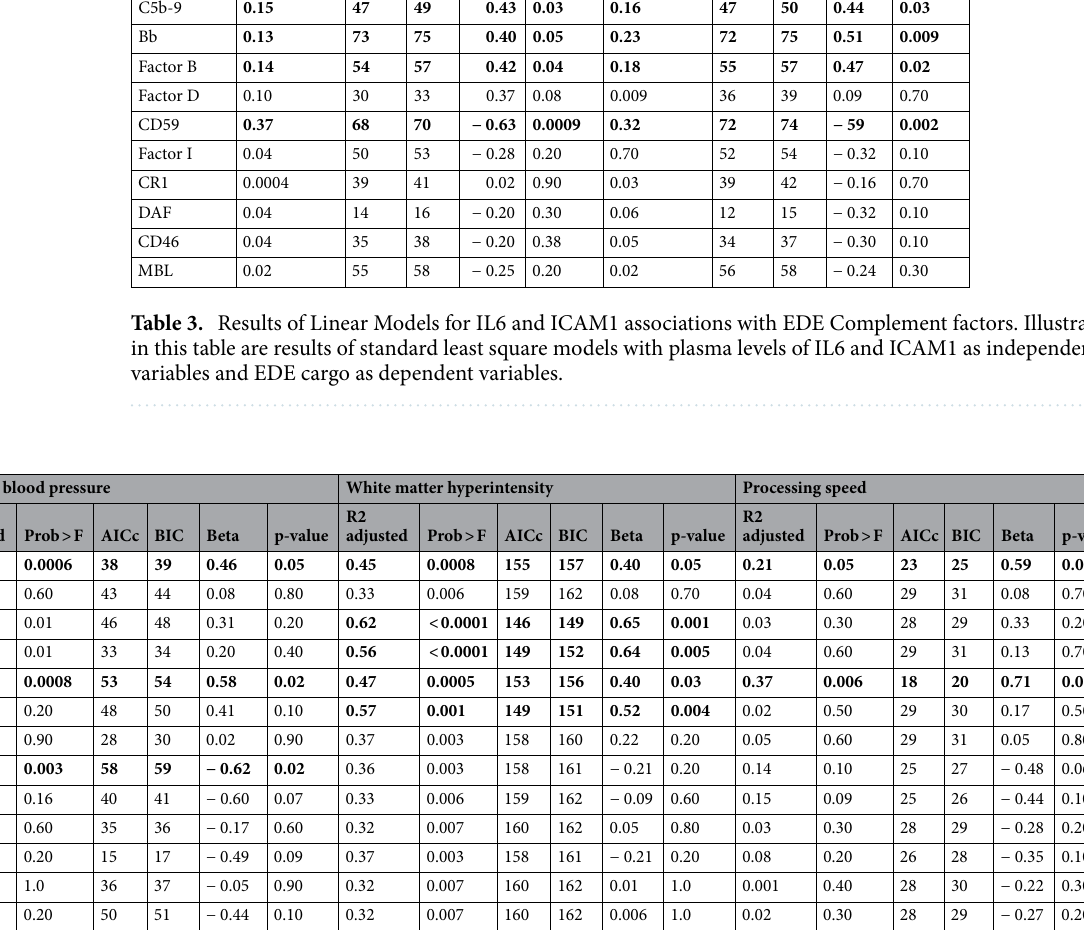
Table 4. Relationship between EDE complement proteins and clinical factors. Illustrated in this table are results of standard least square models with: (1) systolic blood pressure as independent variable and complement factors as dependent; (2) complement factors as independent and global volume of white matter hyperintensity as dependent; (3) complement factors as independent and cognitive processing speed (based on time taken to complete the modified Trails test) as dependent. Age was adjusted for in all models. All p-values are FDR-corrected for multiple